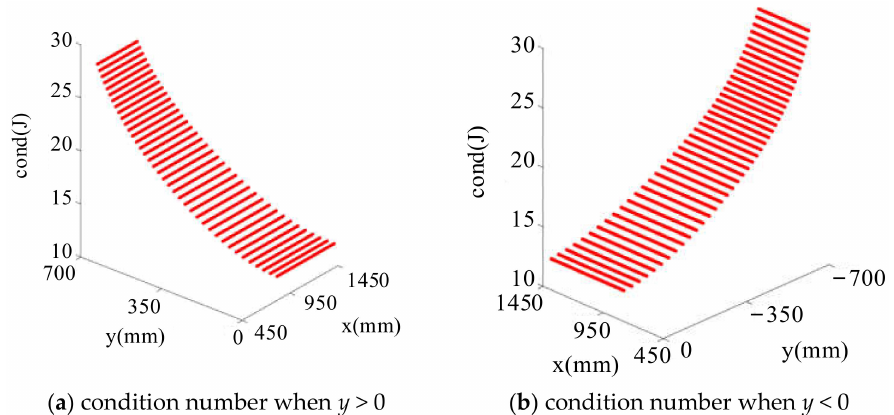
Figure 9. Jacobian condition